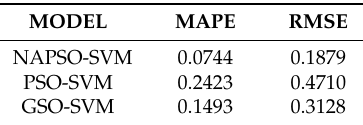
Table 2. Comparison of the index value among the three models (case 1).